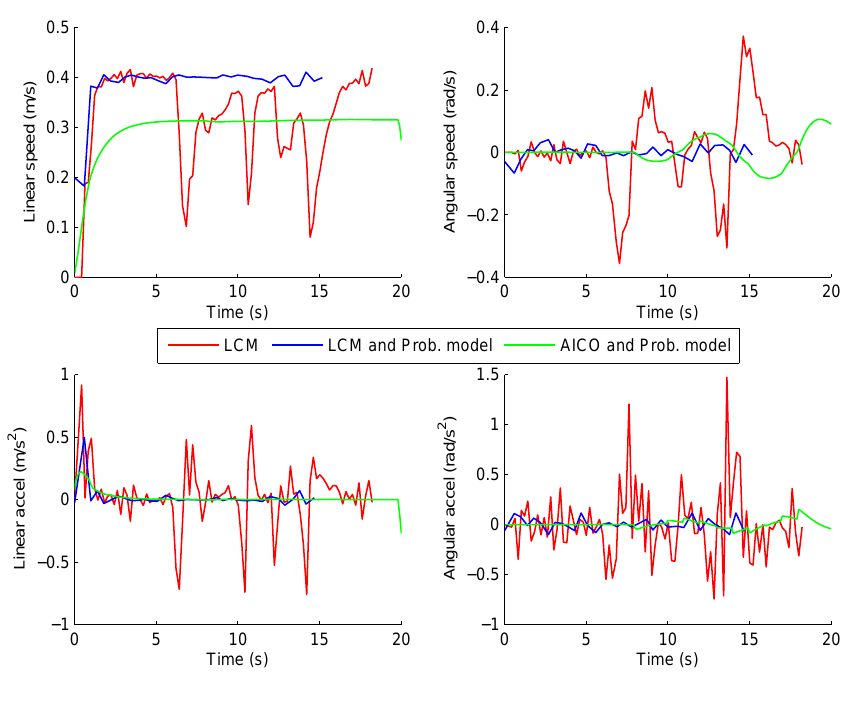
Figure 10. Velocities and accelerations using LCM and AICO: parallel scenario.